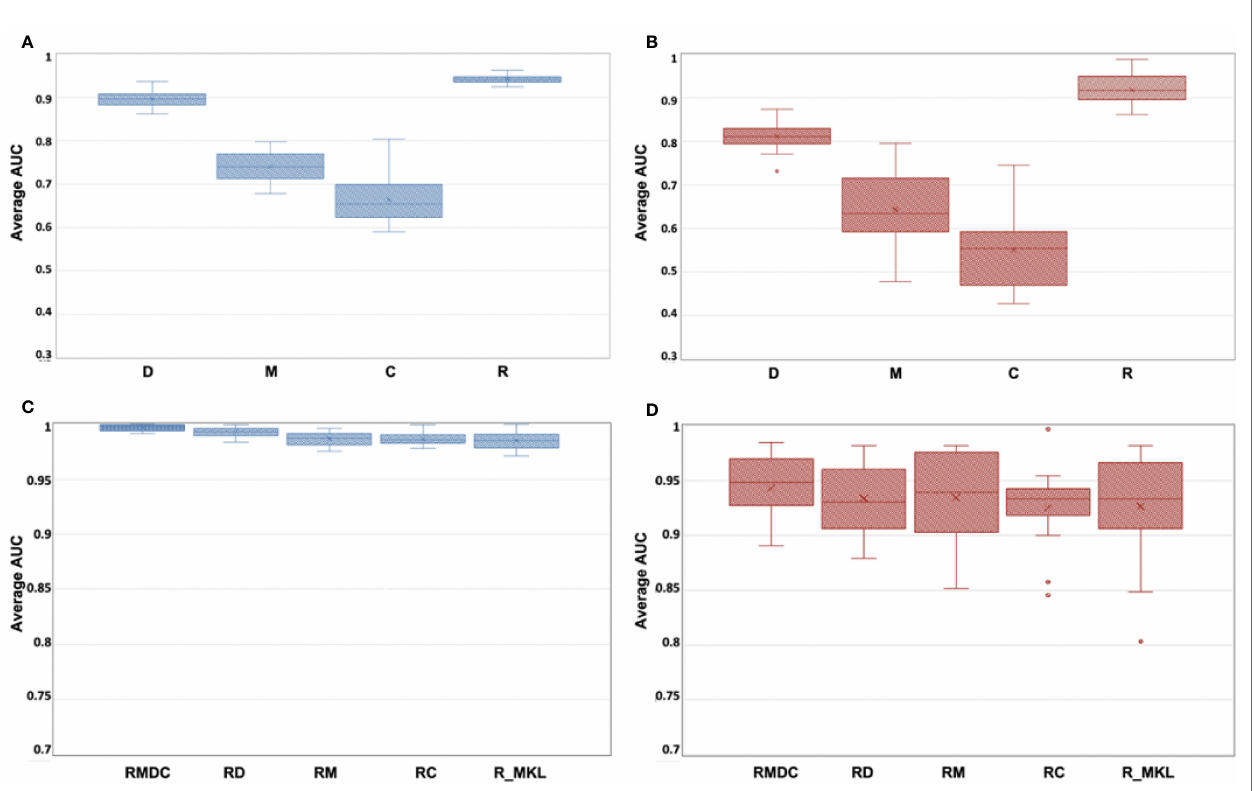
Number of Final Selected